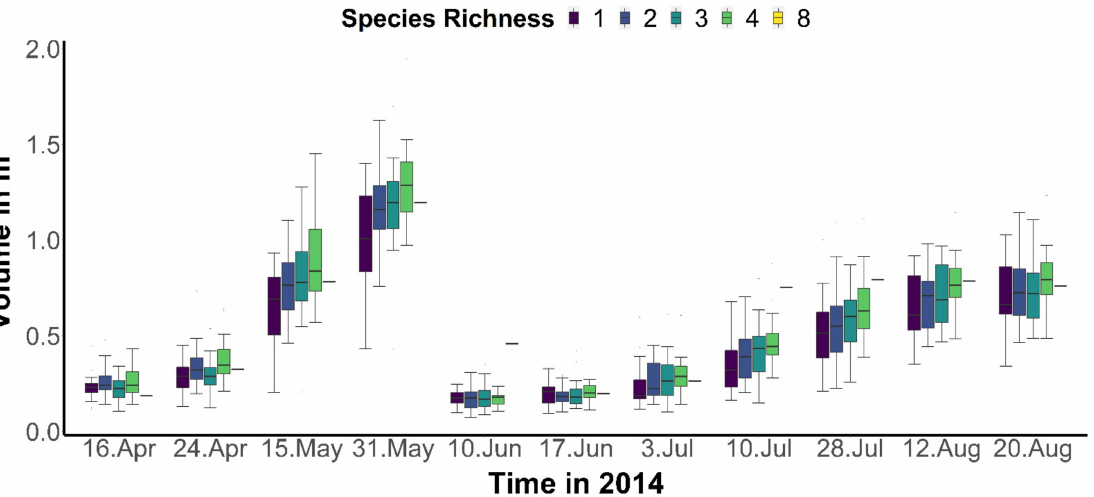
Figure 2. Temporal distribution of total volume per time slice throughout the growing season in 2014. The total volume calculated based on voxelization technique is displayed across the experimental species richness gradient in colored code. Note that the eight-species communities represent two communities in our database, therefore the mean lines have lower variance than other communities and the interquartile ranges in the boxplot are not